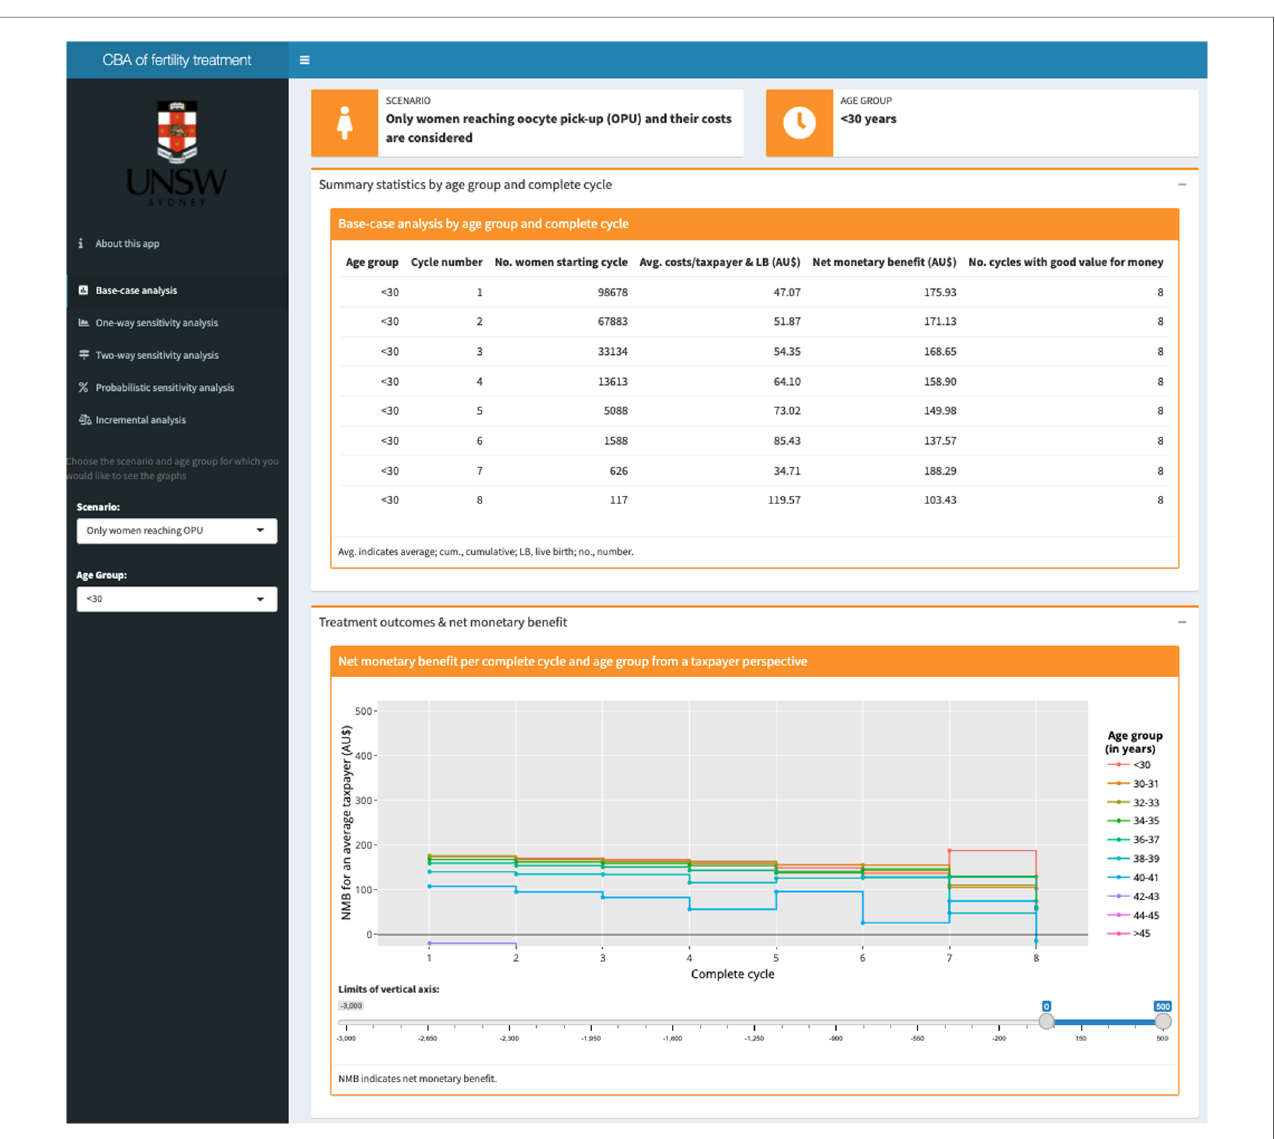
FIGURE 3 Screenshot of the base-case analysis results page in the interactive online app showing (1) a table with summary statistics at the top; and (2) a graph plotting the net monetary bene fi t across all cycles by age group at the bottom. Based on the selection in the dark grey panel on the left for the (1) scenario (per OPU or per initiated cycle) and (2) age group, tables and fi gures are automatically